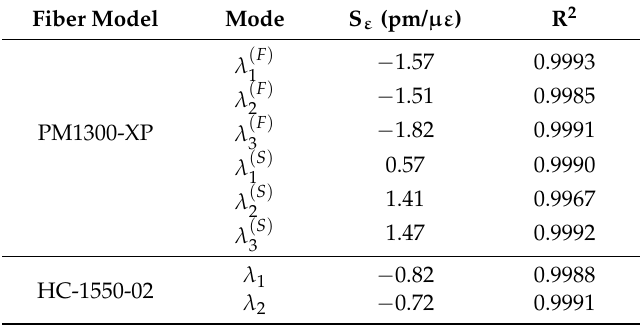
Table 3. Strain sensitivity of